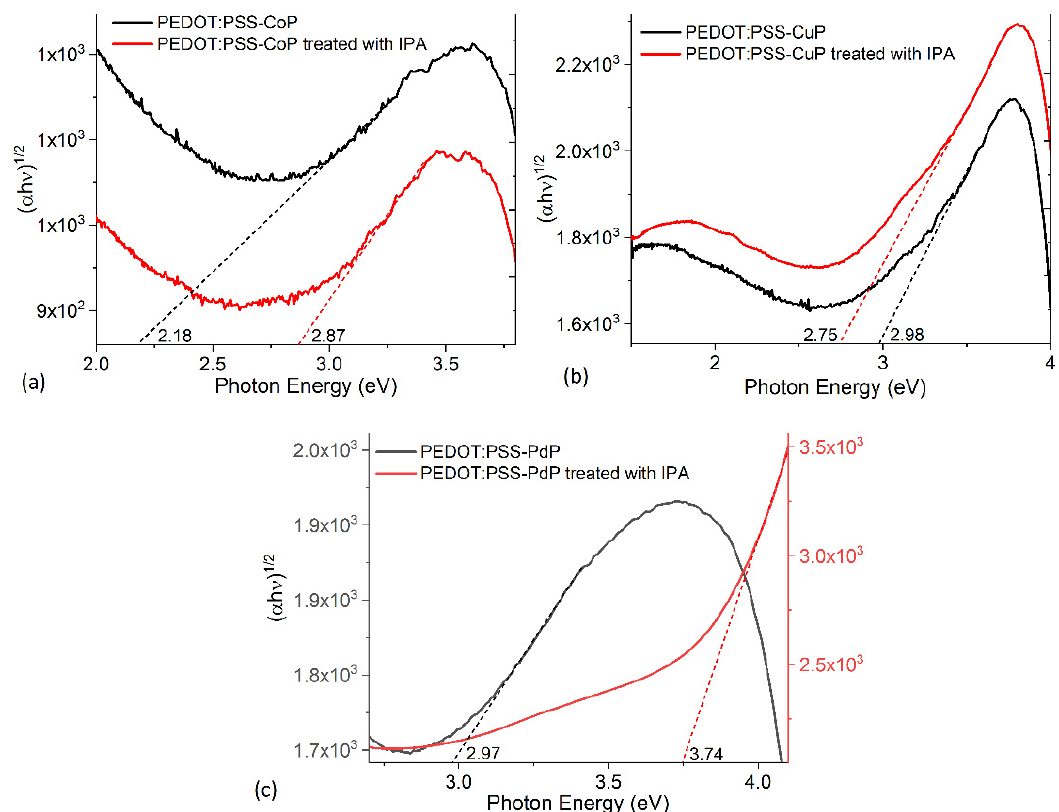
Figure 7. Bandgap plots for ( a ) PEDOT:PSS-CoP, ( b ) PEDOT:PSS-CuP, and ( c ) PEDOT:PSS-PdP films without and with IPA treatment.